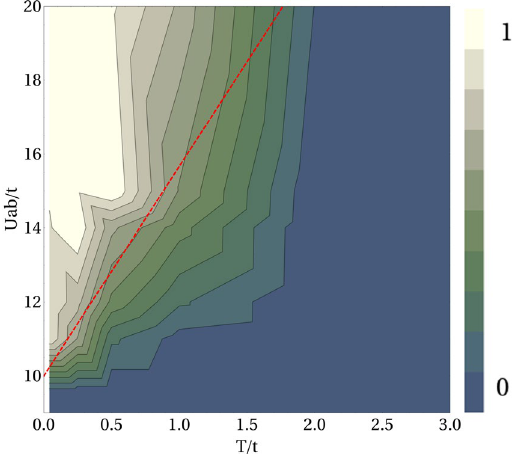
Figure 6. Contour-plot of Δ as a function of temperature T / t and interspecies interactions U ab / t , at U / t = 10. Total filling n = 2 and linear size of the lattice L = 24 (same data of Fig. 2, right panel). Red-dashed line shows critical boundary between the demixed and mixed phases computed theoretically through the relation = − k